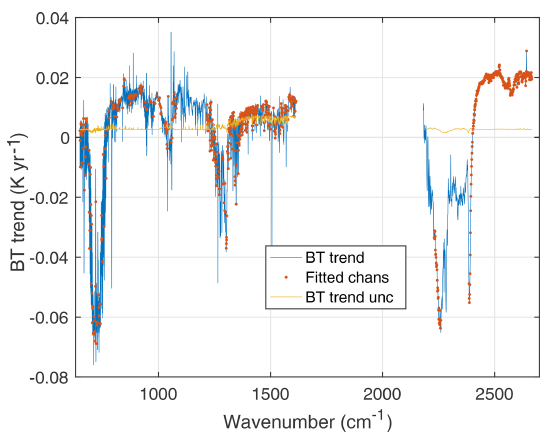
Figure 4. Mean and standard deviation of the AIRS BT anomalies for the zonal bin centered at 28.3 ◦